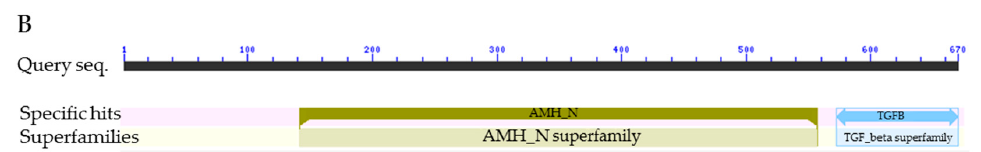
Figure 1. Nucleotide and deduced amino acid sequences as well as the predicted structural domains of anti-Müllerian hormone ( AMH) gene in geese. ( A ) Nucleotides and amino acids sequence were displayed from the 5 ′ to the 3 ′ direction and the locations of both nucleotide and amino acid were numbered on the left side. The entire deduced amino acid sequence is depicted in single letter code beneath the corresponding nucleotide sequence. The stop codon TGA is with ‘*’. ( B ) The location of predicted structural domains in the amino acid sequence of goose AMH . The number upon the query sequence represents the number of amino acids.